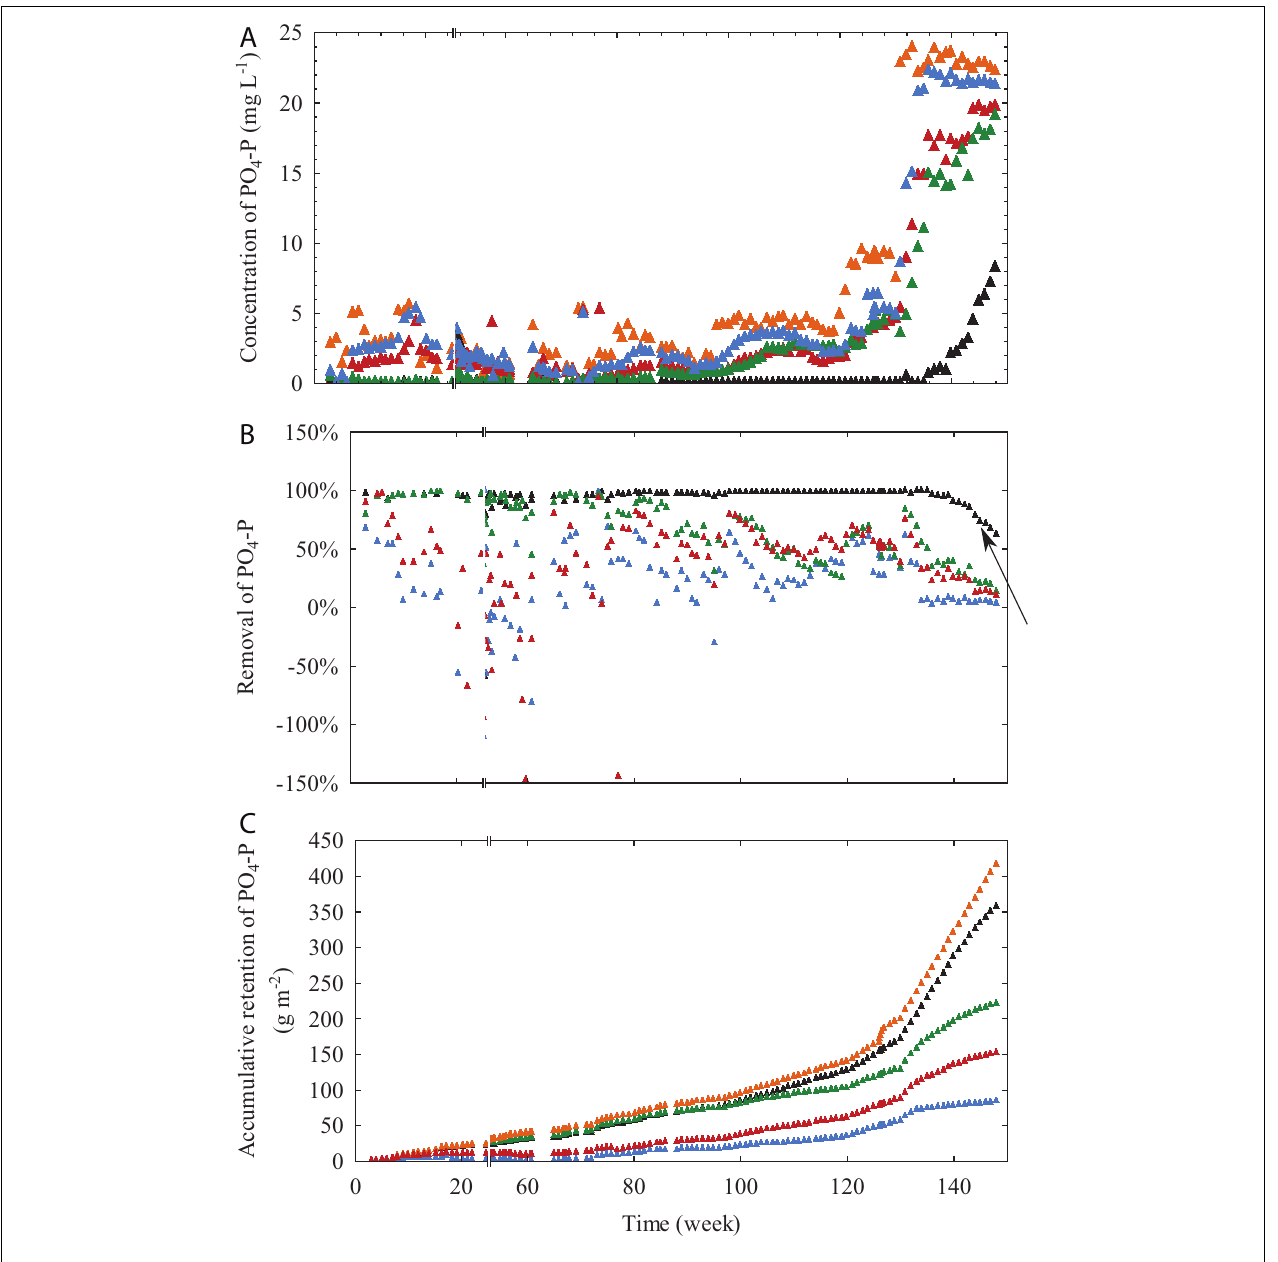
FIGURE 4 | (A) Concentration of phosphate-phosphorus (PO 4 -P) in the inflow to filters, (B) removal of PO 4 -P in filters, and (C) cumulative amount of PO 4 -P retained (mg m − 2 ) from start to end of the experiment in: unimpregnated biochar filter (UBC; blue), CaO-impregnated biochar filter (CBC; green), FeCl 3 -impregnated biochar filter (FBC; black), and biochar filter mixed with Polonite R (cid:13) (PBC; red). The orange line in panel (C) shows cumulative amount of PO 4 -P (g m − 2 ) applied to the